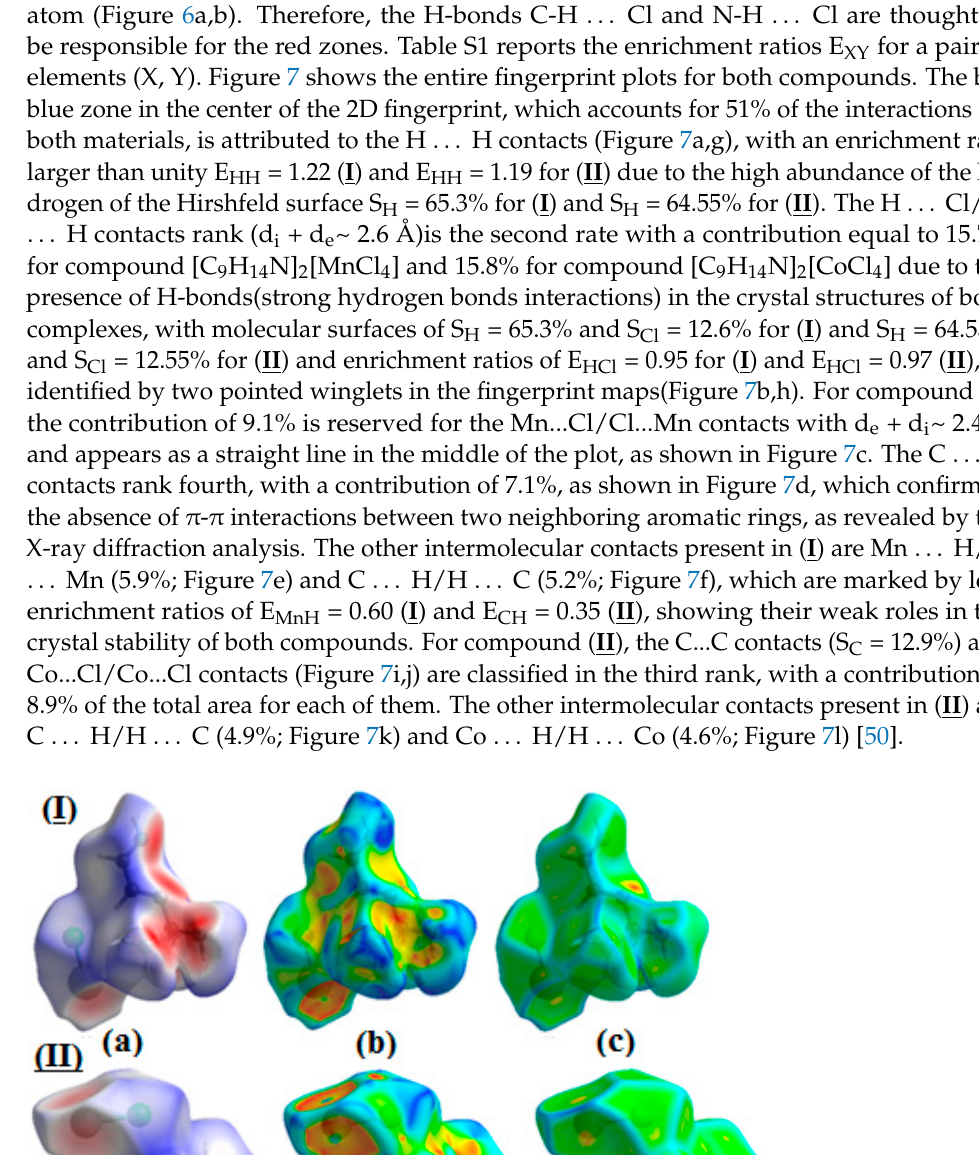
Figure 6. H-bonds present in compound [C 9 H 14 N] 2 [MnCl 4 ] ( a ) and in compound [C 9 H 14 N] 2 [CoCl 4 ] ( b ).